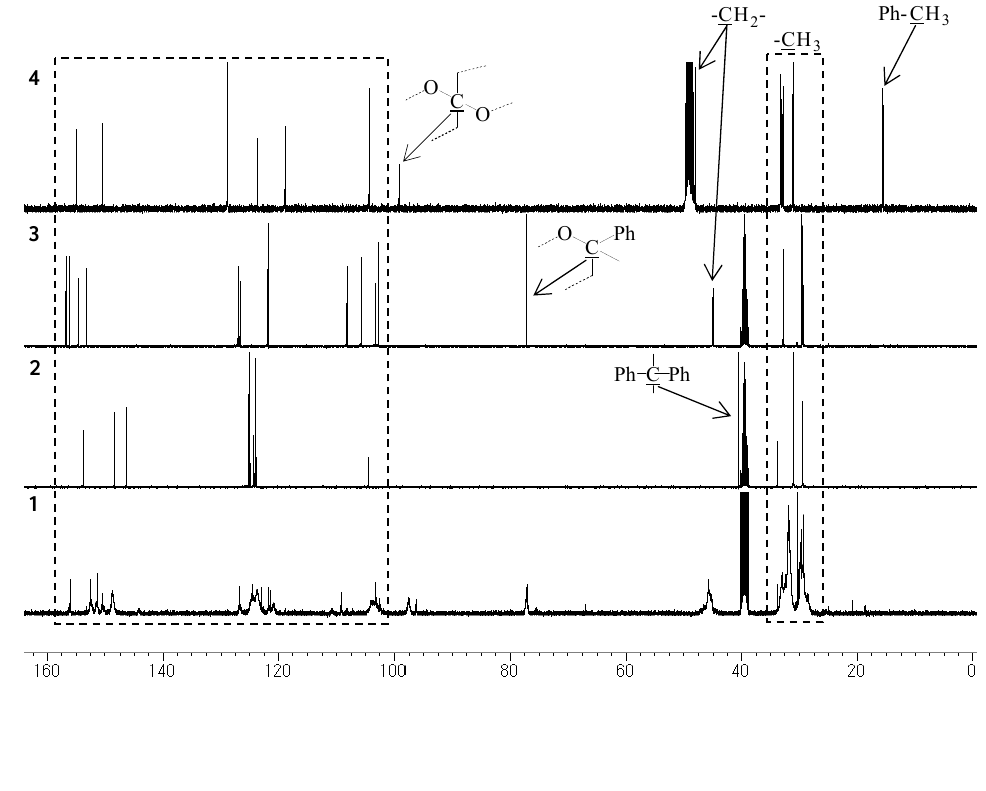
Figure 3 . 13 C-NMR spectra of 1 , 2 , 3 (DMSO, 100 MHz), and 4 (MeOH, 100